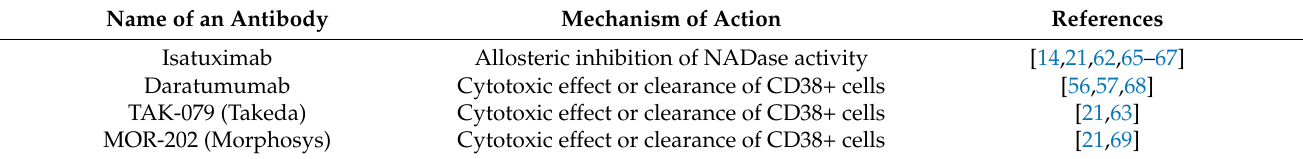
Table 1. Types of anti-CD38 antibodies used in the therapy of CD38+ malignancies and mechanisms of their